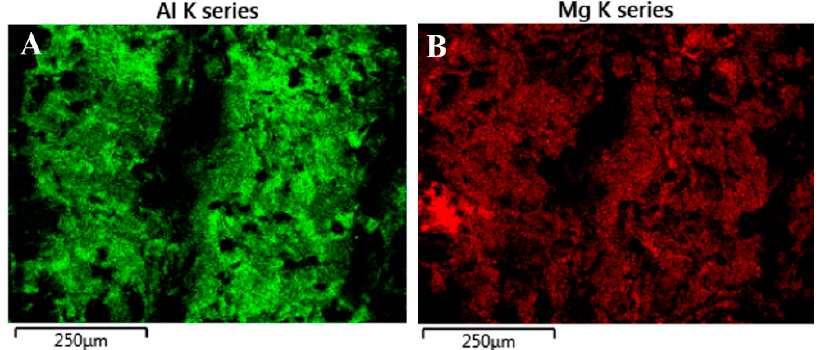
Figure 8. The results of the element distribution on the fracture surface of Mg/Al mini-specimen after hot-rolling at 400 °C: aluminum ( A ) and magnesium ( B ).